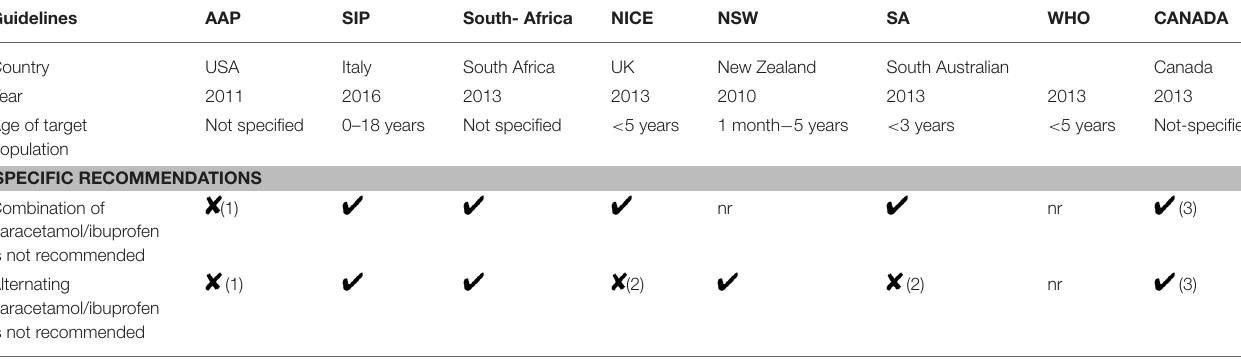
TABLE 1 | Management of fever guidelines (from 29,